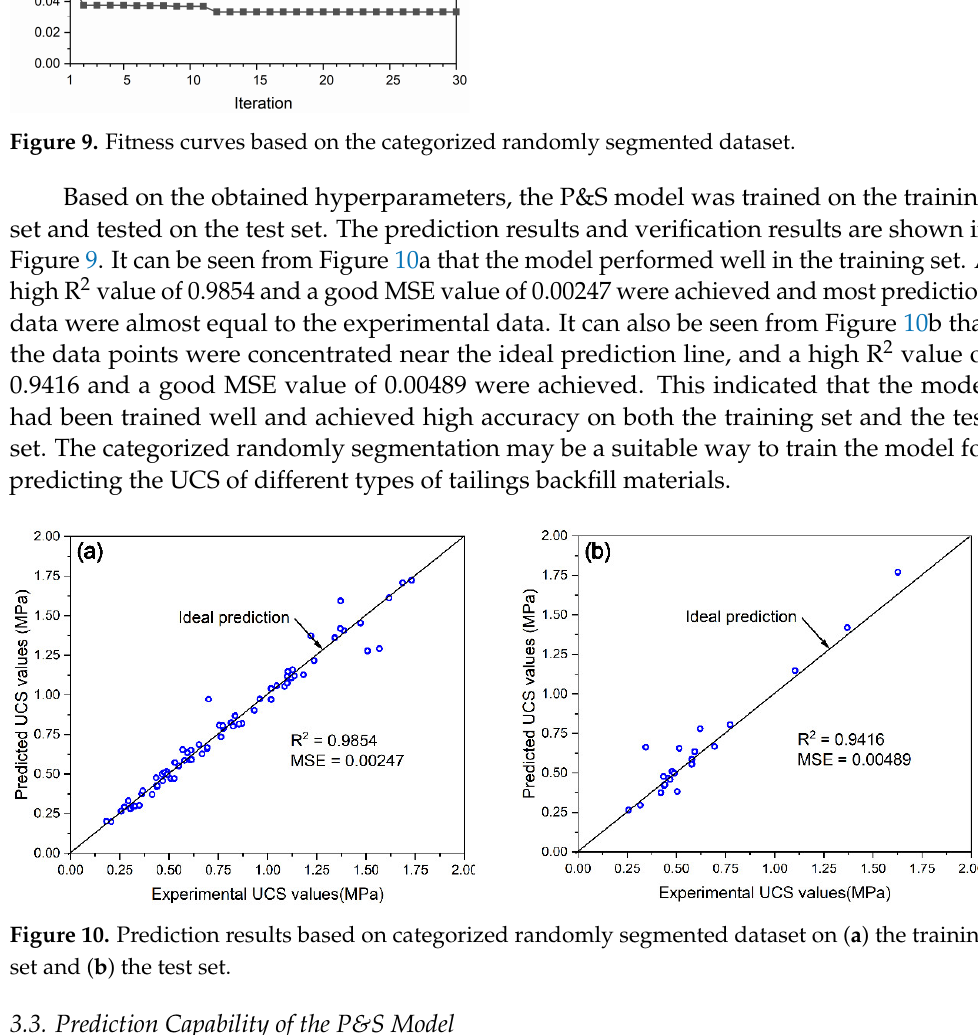
Figure 11. Comparison of UCS values obtained from the experimental investigation and P&S model prediction.